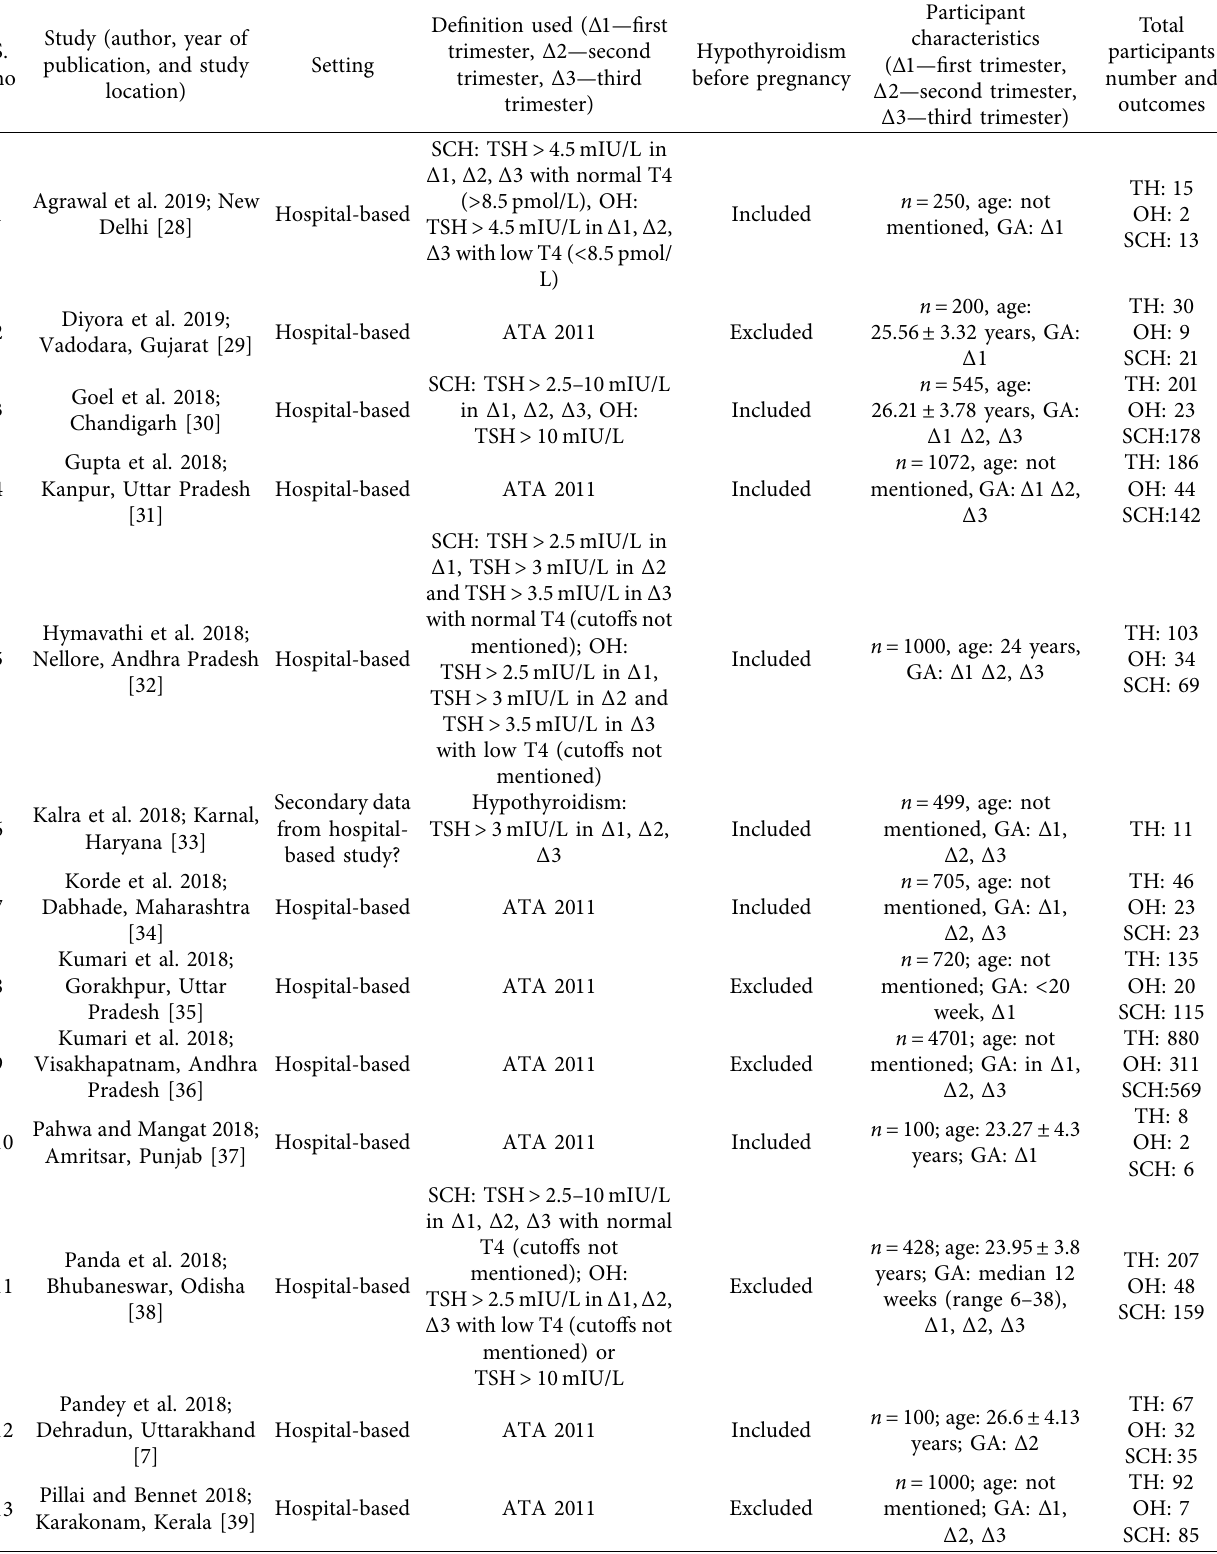
Table 1: Summary of included